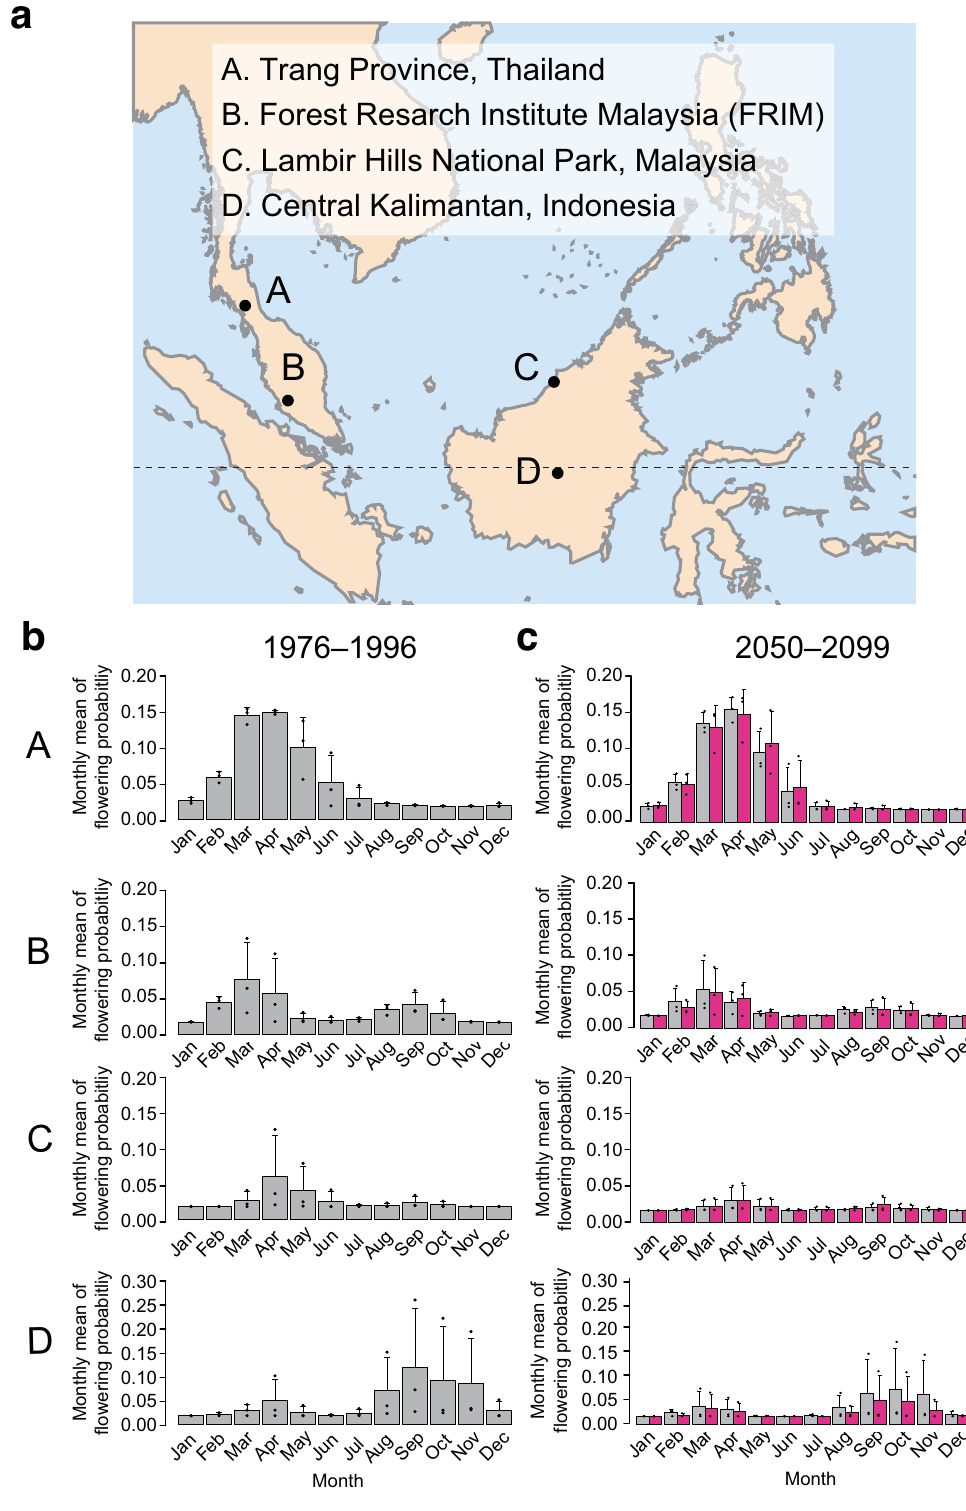
Fig. 6 Comparison of predicted fl owering phenology across four regions in Southeast Asia. a A map illustrating the four study sites (A – D) used for phenology forecasting. The dotted line indicates the equator. b Means ± standard errors of the monthly fl owering probability predicted during the 1976 – 1996 period. c Means ± standard errors of the monthly fl owering probability predicted during the 2050 – 2099 period in the four studied regions. The means and standard errors across three GCMs were calculated from predictions by GDFL – EMS2M, IPSL – CM5A-LR, and MIROC5. A – D corresponds to each of the four study sites in the map ( a